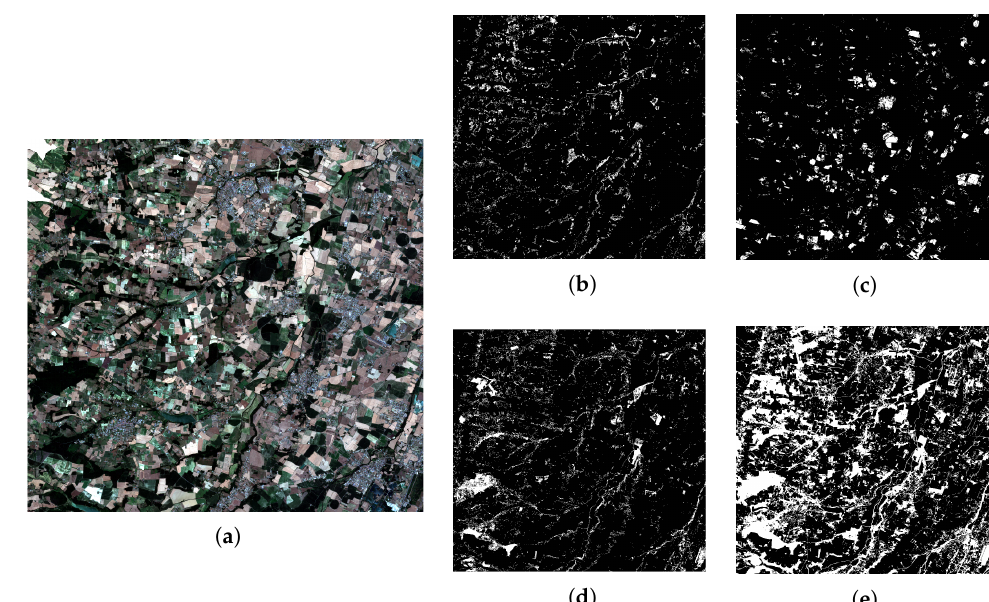
Figure 11. A second visual evaluation zone with ( a ) its RGB composite and the corresponding binary classification maps for ( b ) RF PUL , ( c ) ENSEMBLE PUL , ( d ) OCSVM, and ( e ) PUL-SITS for the positive class Forest with the number of positive training data objects ( n ) equal to 80.